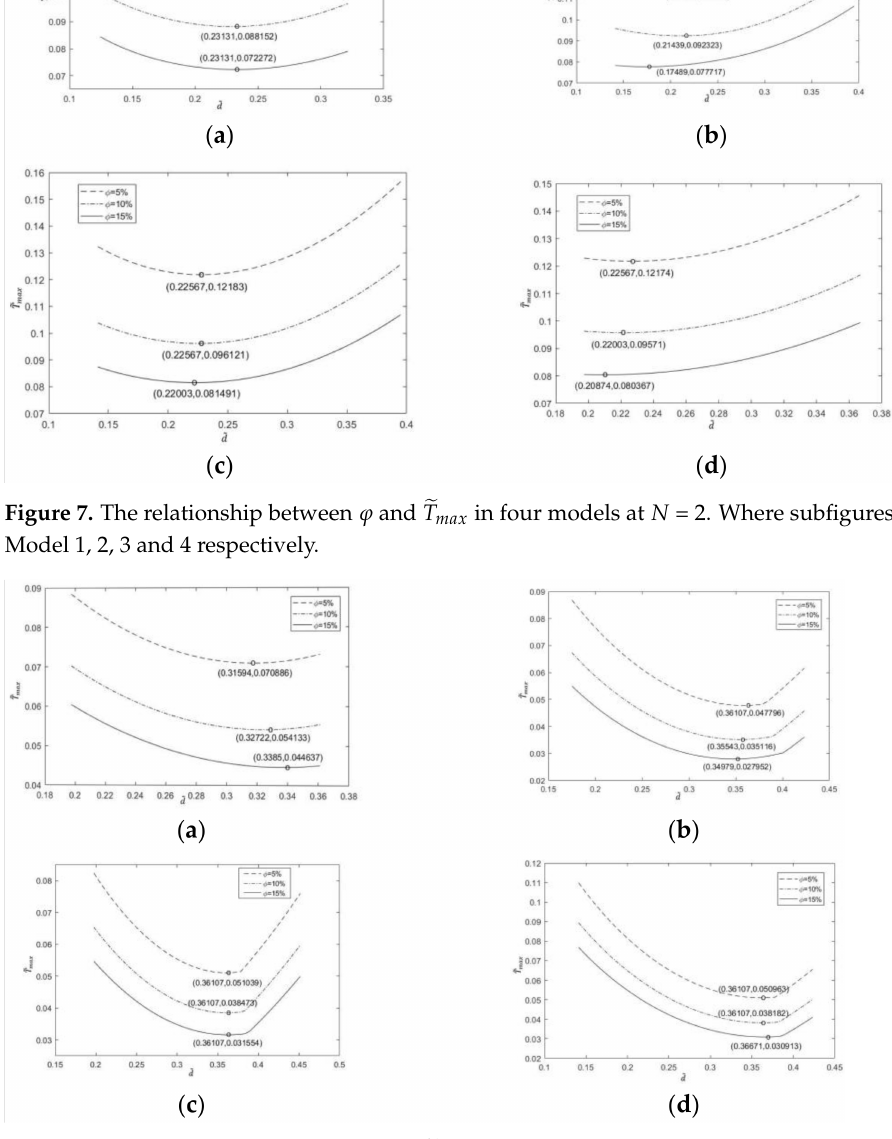
Figure 8. The relationship between ϕ and (cid:101) T max in four models at N = 4. Where subfigures ( a – d ) are Model 1, 2, 3 and 4 respectively.